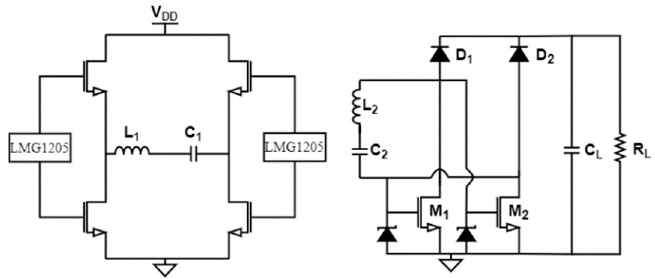
Figure 29. Basic circuit of wireless charger with self-driven rectifier.